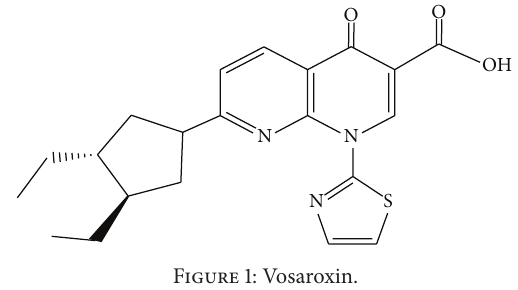
Figure 1: Vosaroxin.